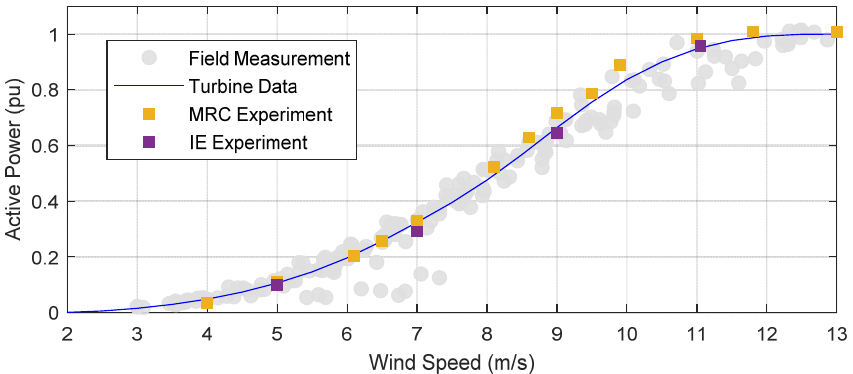
Figure 7. Power curve of the tested wind turbine derived at the test bench with the Inertia Emulation Method and Model Reference Control, in the field and from the turbine’s data sheet.